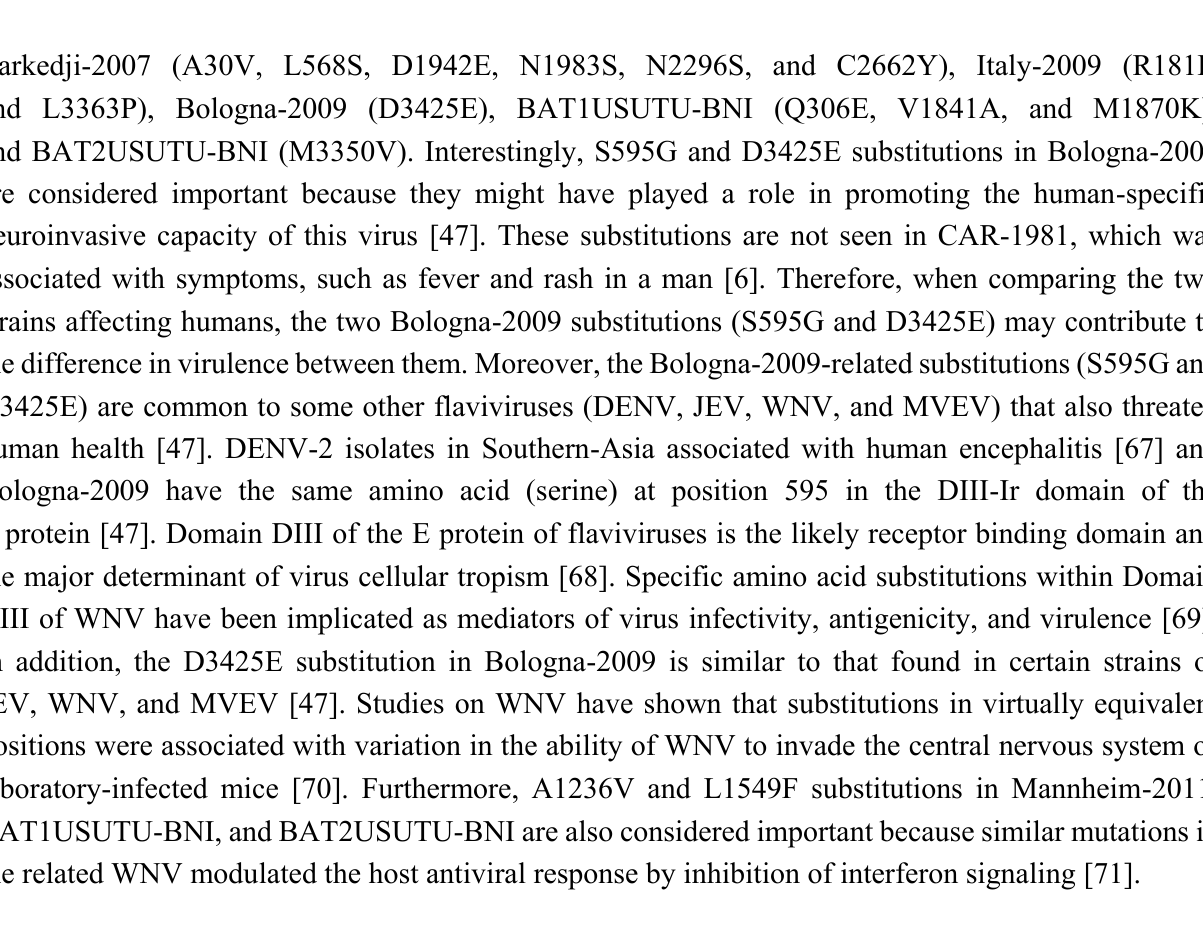
Table 3. Nucleotide and amino acid sequence similarity in fully sequenced USUV strains. Geographical Genome Total Nucleotide Strain